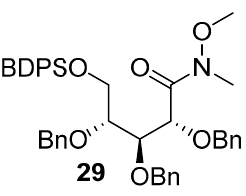
Figure 9. The structure of Weinreb amide 29 .